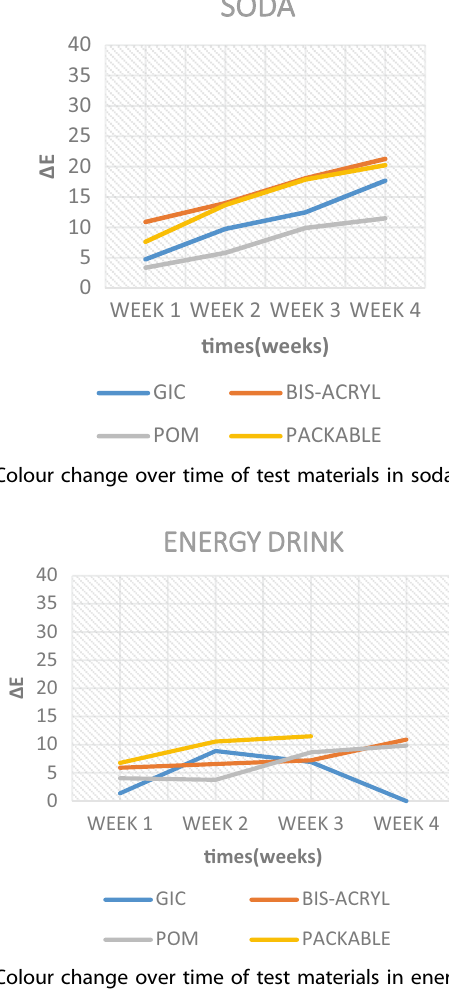
Fig. 8 Colour change over time of test materials in black